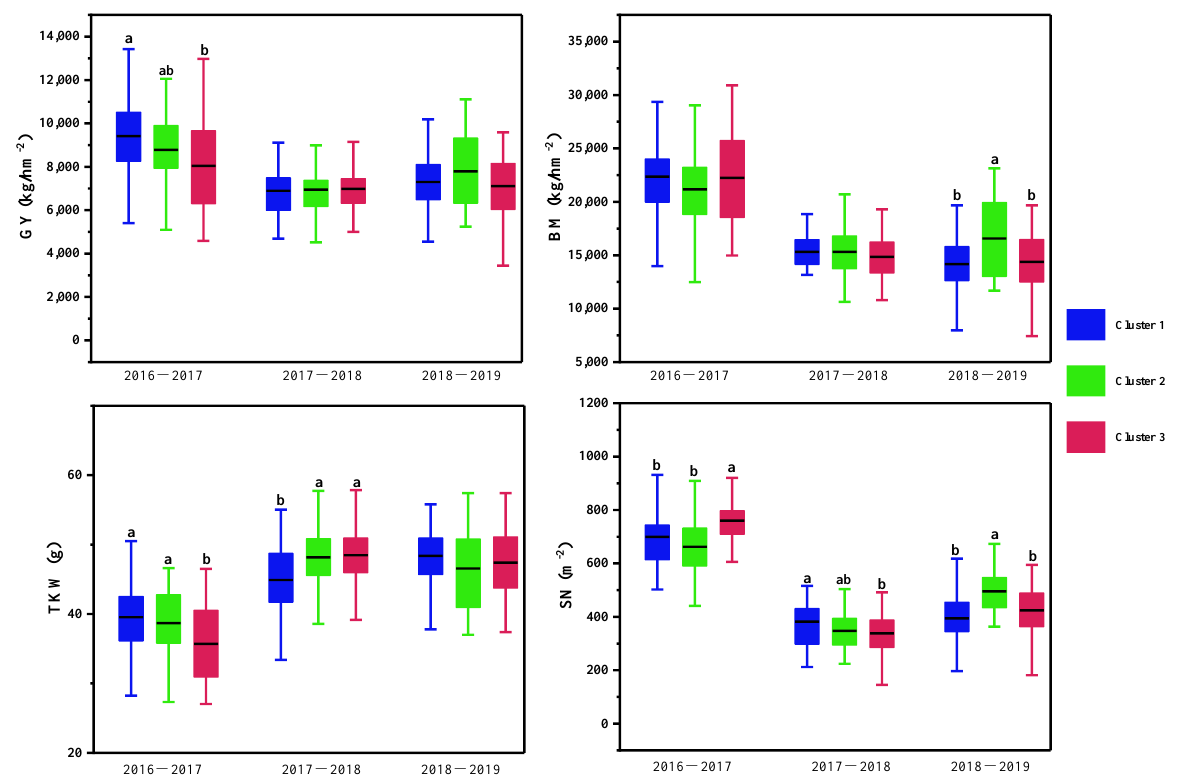
Figure 6. Multiple comparisons of yield traits among the three clusters based on the CTD at three growth stages and canopy structural traits for each growing season. The clustering was conducted with the CTD at the three growth stages and structural traits for each growing season using the Ward method. Then multiple comparisons were conducted among different clusters using the Duncan method, different lowercase letters indicated the differences significant at the p < 0.05 level. SN: spike number per m 2 ; TKW: 1000-kernel weight; GY: grain yield; BM: